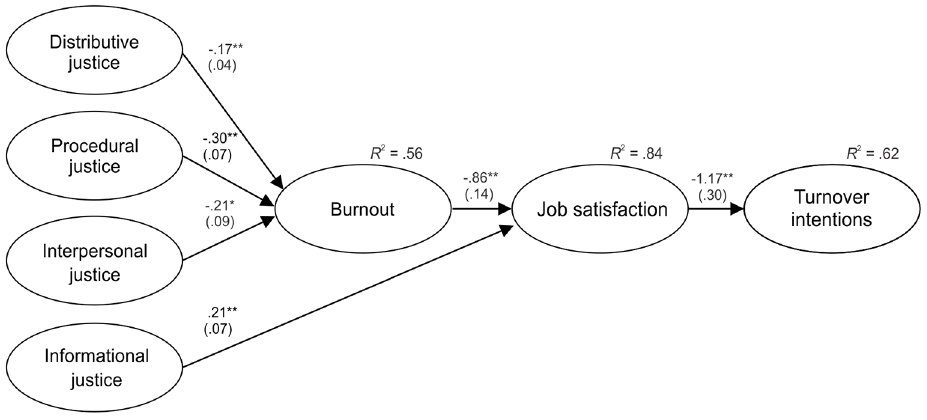
Figure 2. Final serial mediation